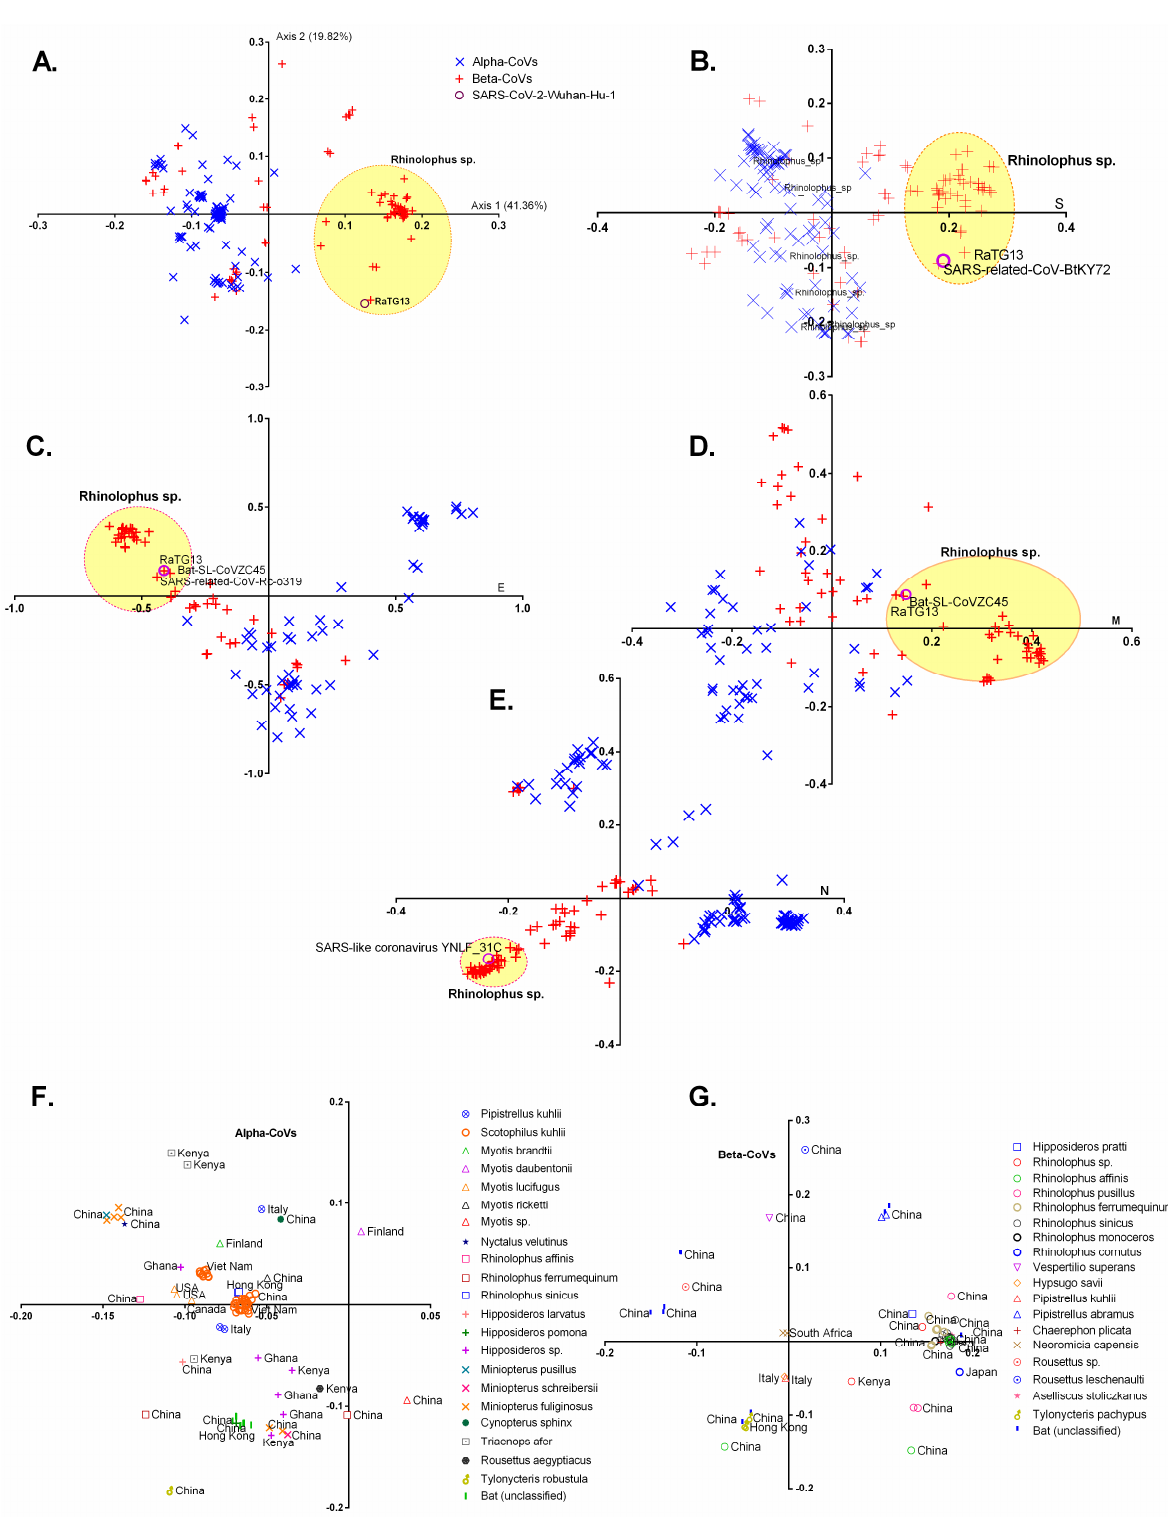
Figure 3. Correspondence analyses based on relative synonymous codon usage in the entire coding genomic sequences ( A ), spike ( B ), envelope ( C ), membrane ( D ), and nucleo-capsid ( E ) encoding sequences of chiroptera-hosted alpha- and beta-CoVs. ( F , G ) show trends in relative synonymous codon usage among CoVs infecting various bat species across different geographical locations. The viruses infecting Rhinolophus sp. are encircled and